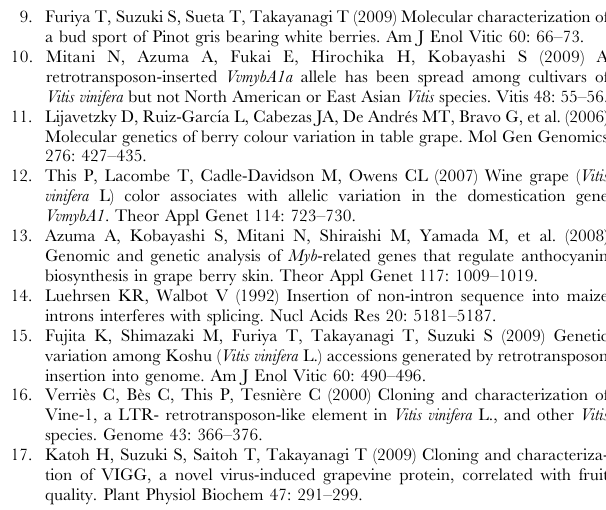
Figure S2 Alignment of the nucleotide sequences of the MybA1 gene between Koshu and Cabernet Sauvignon. (A) Promoter and coding regions of MybA1 in the red allele. (B) MybA1 coding regions in the white allele. Koshu has three additional gene fragments (44 bp, 111 bp, and 33 bp, shaded black) in the red allele of the MybA1 gene relative to the sequence of Cabernet Sauvignon. The DNA sequence of the MybA1 gene of the white allele is identical between Koshu and Cabernet Sauvignon. CS,